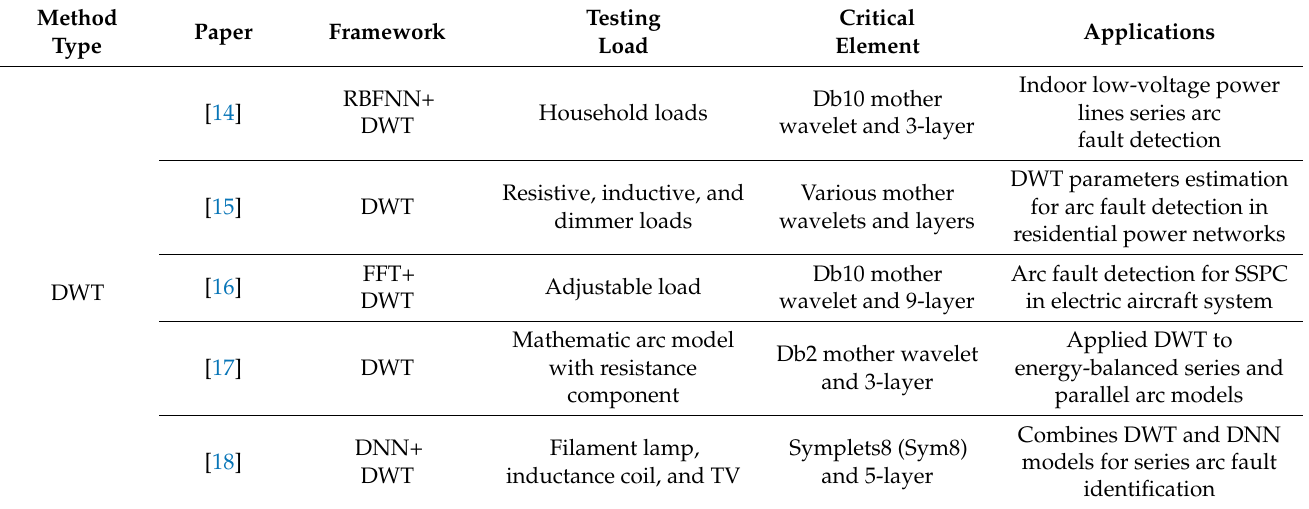
Table 3. Comparisons of different method